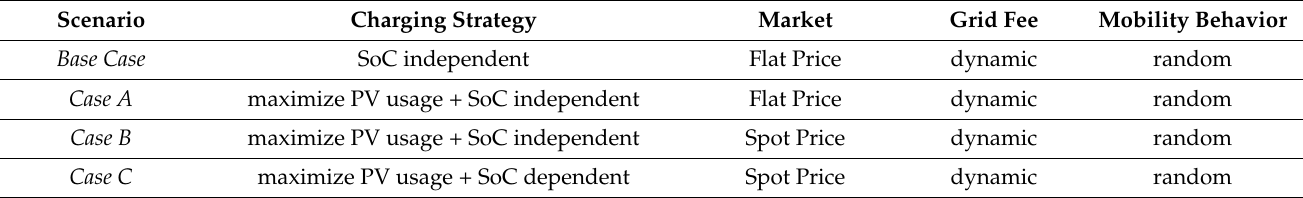
Table 1. Simulation parameters of investigated